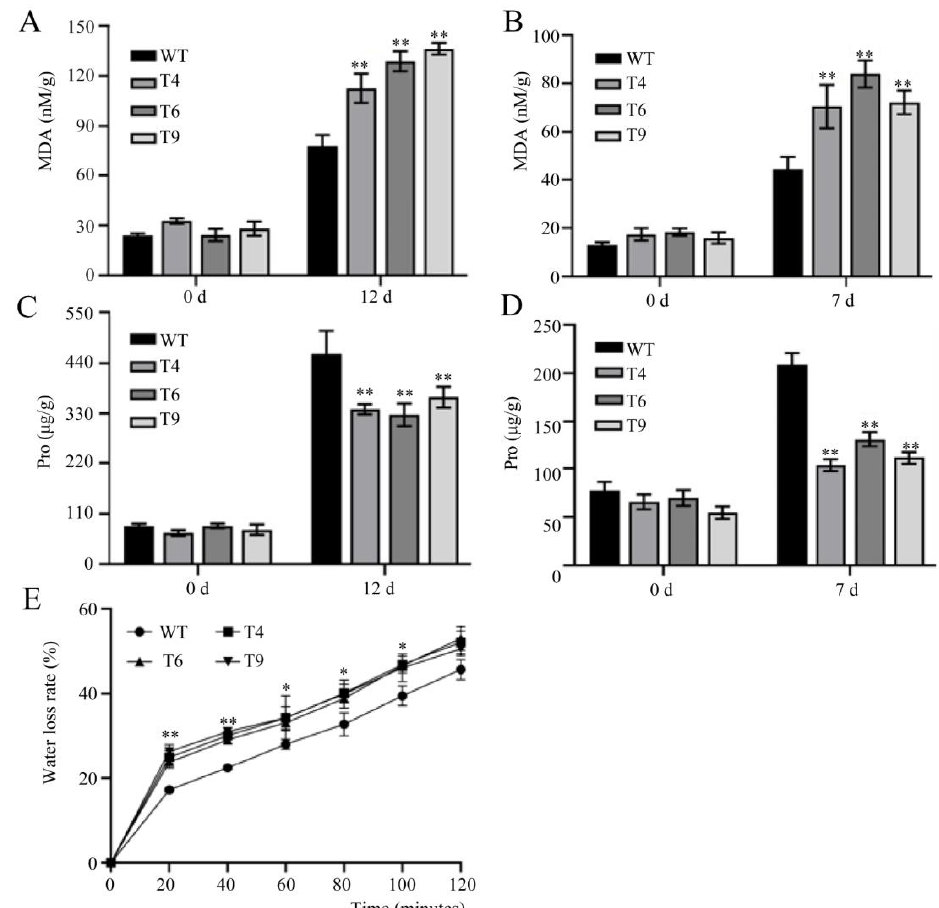
Figure 8. MDA, Pro (proline) content and water loss rate in FtMYB22 transgenic Arabidopsis (T4, T6, and T9) lines and WT lines under stress treatments. ( A ) MDA content in transgenic lines under water deficit treatment. ( B ) MDA content in transgenic lines under salt treatment. ( C ) Proline content in transgenic lines under water deficit treatment. ( D ) Proline content in transgenic lines under salt treatment. ( E ) Water loss rate in isolated leaves of FtMYB22 transgenic Arabidopsis . WT, wild-type. Data are shown as mean ± SD derived from three independent experiments. Error bars represent standard errors. ** means extremely significant difference at p < 0.01 level, * means significant difference at p < 0.05 level.